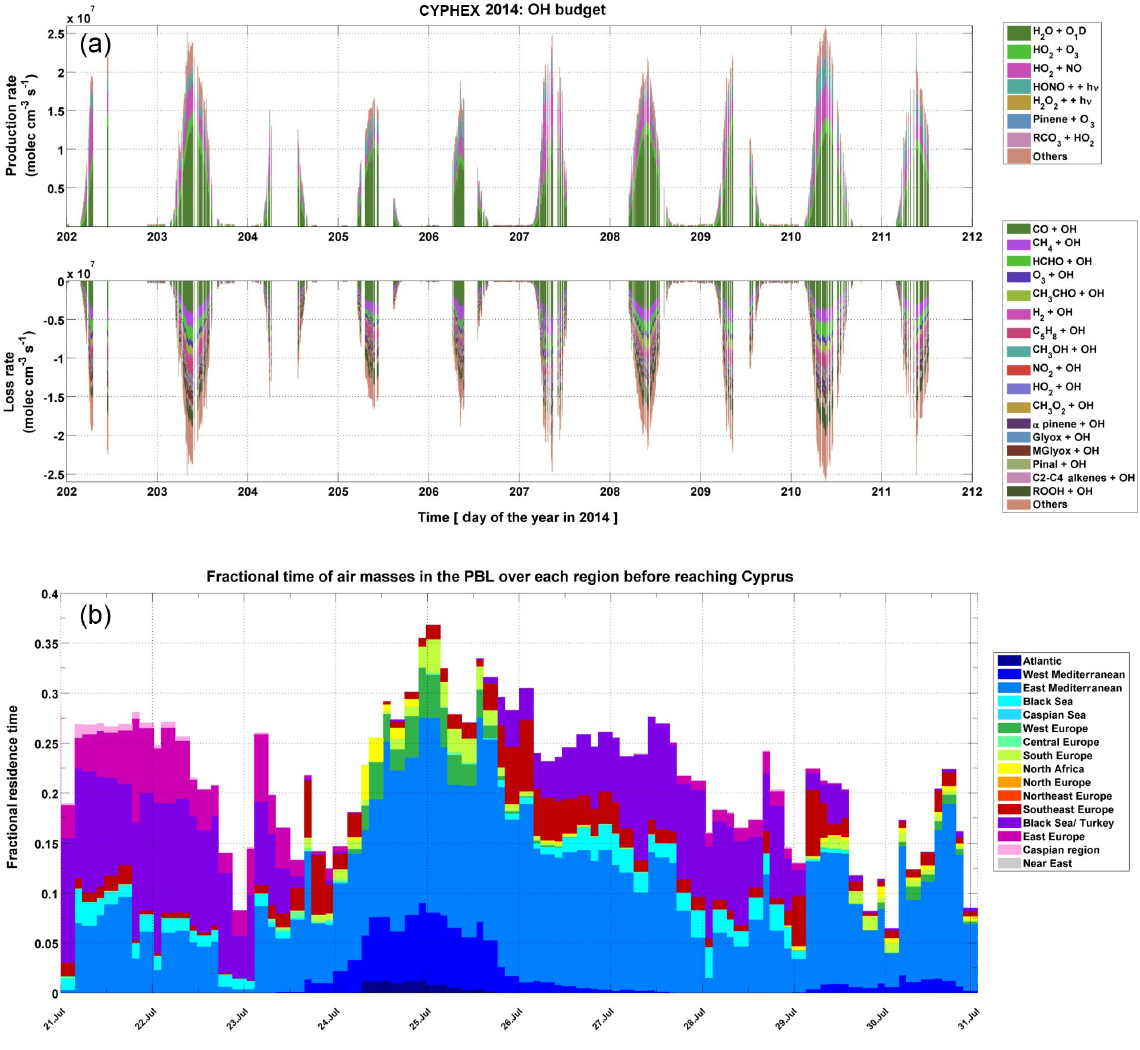
Figure 7. (a) Budget analysis for OH during CYPHEX. The HO x budget is significantly impacted by the changes in air mass source regions. (b) FLEXPART evaluation of the contribution of different source regions within the planetary boundary layer to the air mass origin at the measurement site in Cyprus is shown in (b) . The air mass source regions are shown in a separate colour map (Fig.